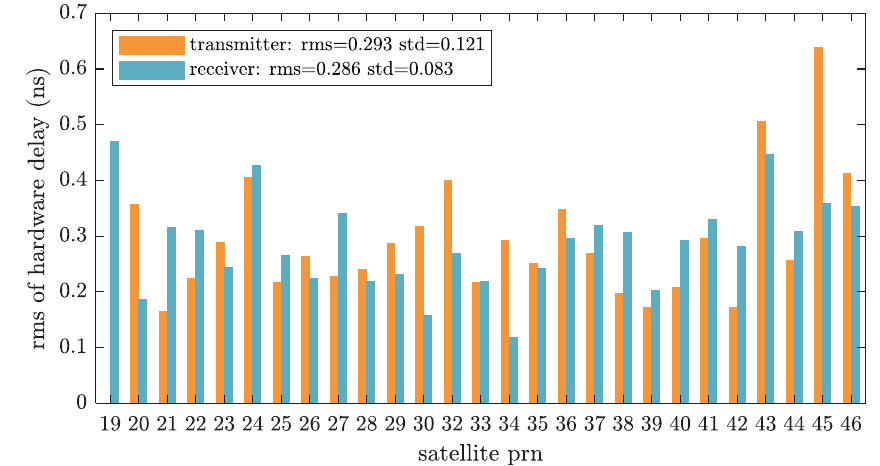
Figure 3: Statistical accuracy of estimated hardware delay via on - orbit data.